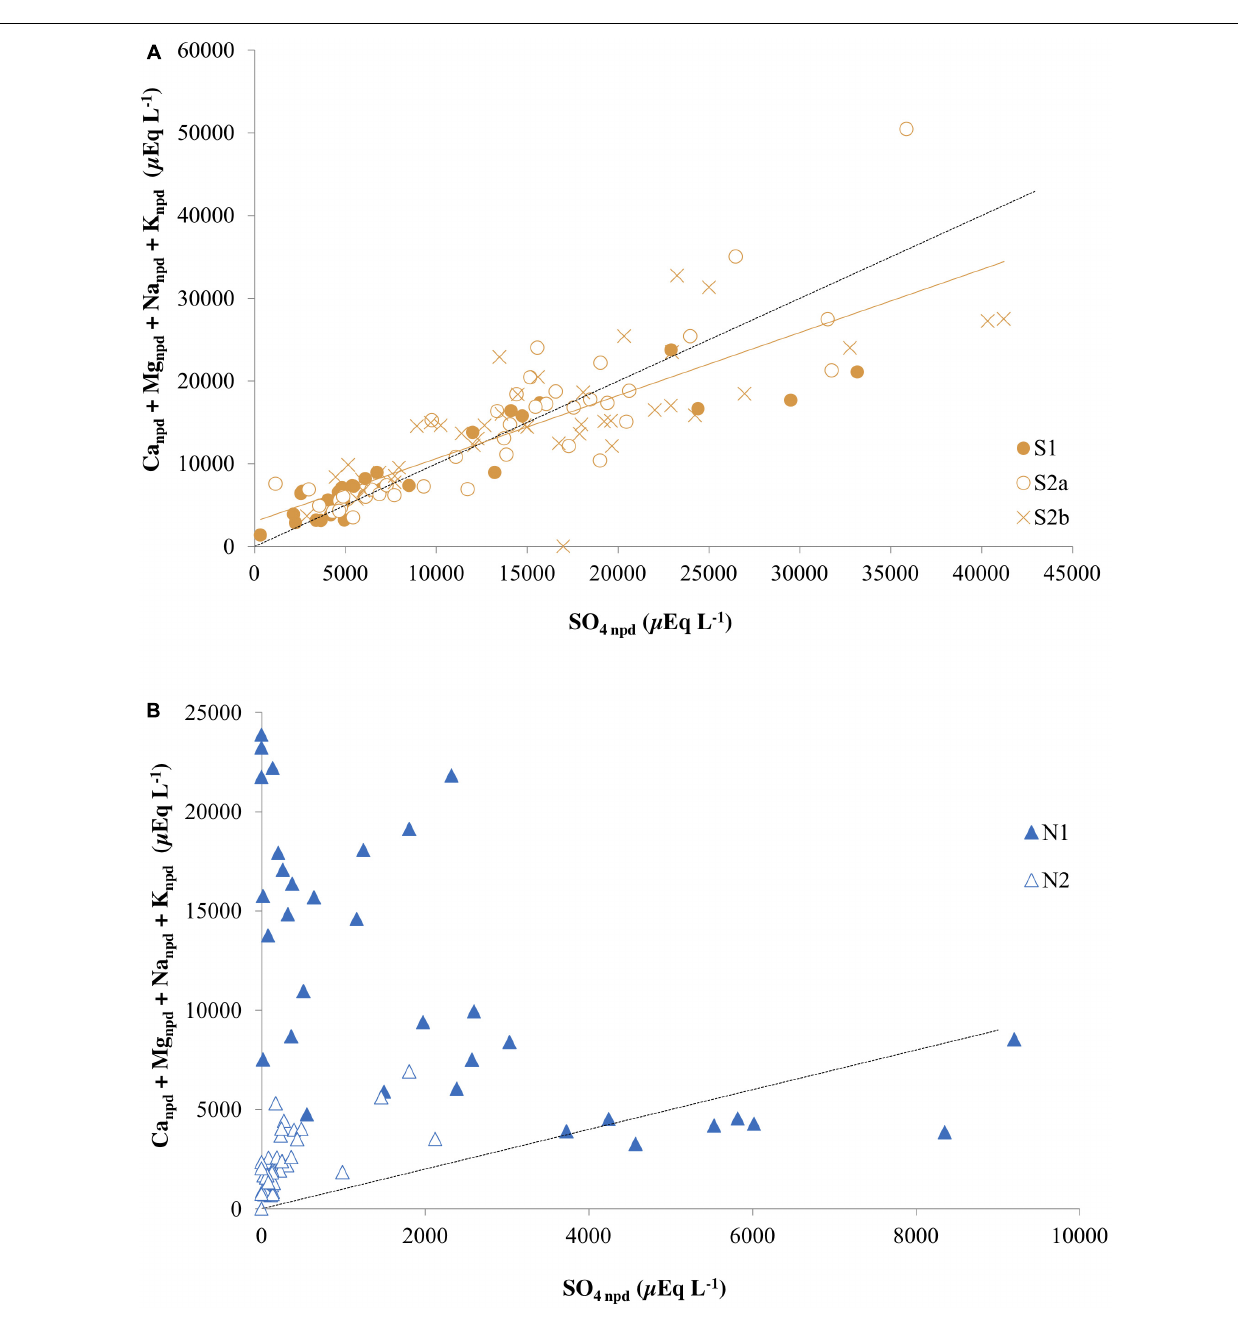
FIGURE 7 | Total non-precipitation-derived base cations and non-precipitation-derived sulfate in (A) the three cores from Ice Wedge South and (B) the two cores from Ice Wedge North. The dashed black line corresponds to a 1:1 relationship between SO 4 npd and (Ca npd + Mg npd + Na npd + K npd ) that represents sulfide oxidation coupled to silicate dissolution. The solid orange line is a regression for all points from the three cores from Ice Wedge South (R 2 =